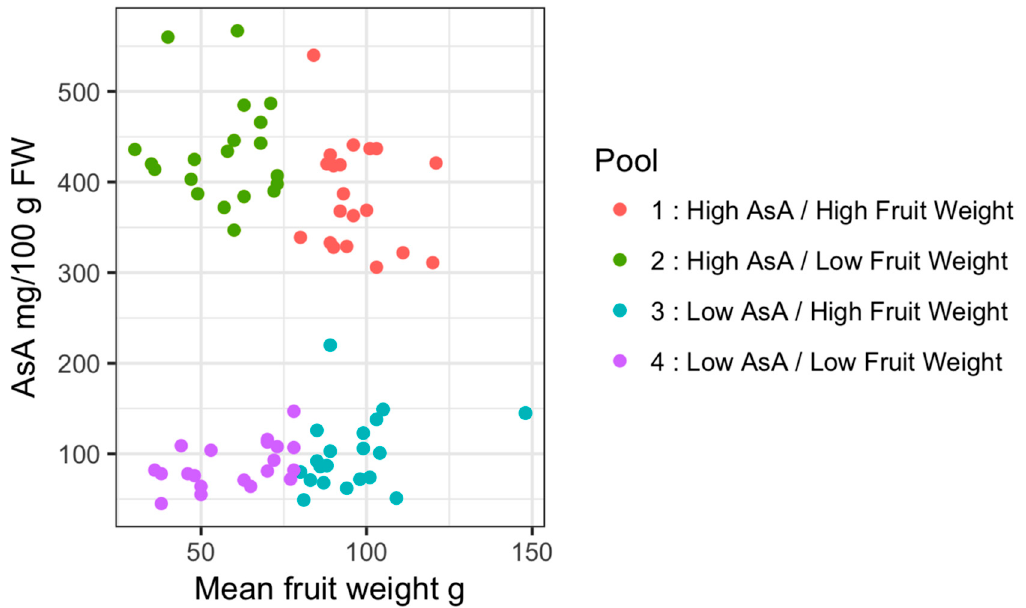
Figure 3. Allocation of samples to sequencing pools.